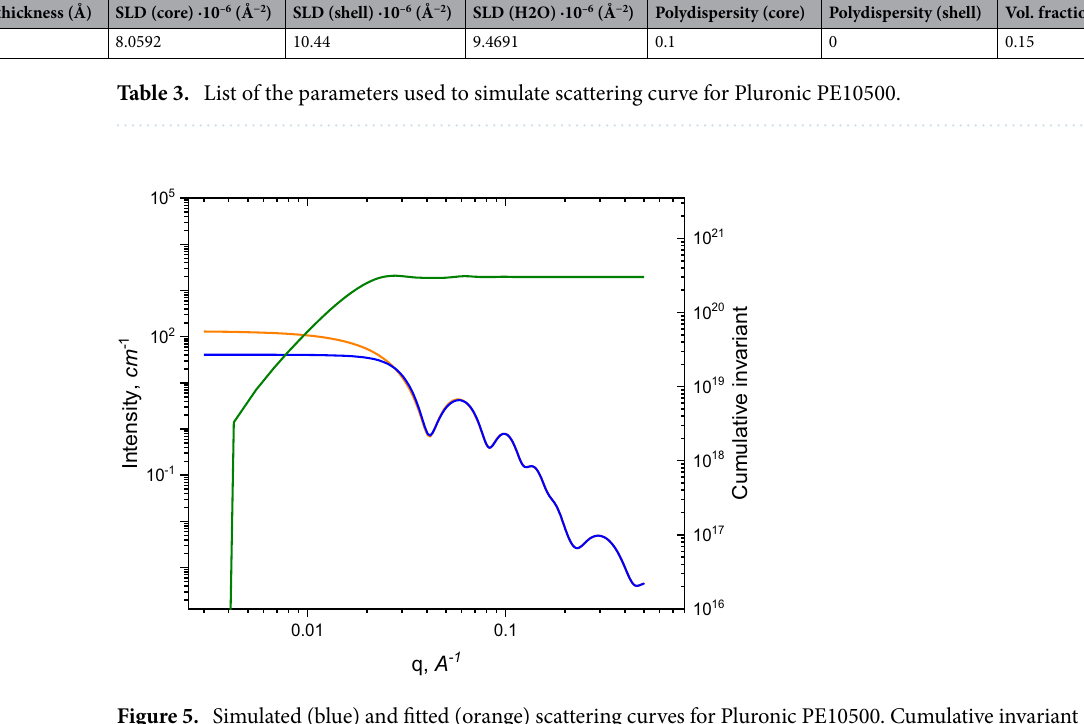
Figure 5. Simulated (blue) and fitted (orange) scattering curves for Pluronic PE10500. Cumulative invariant curve is drawn in green.